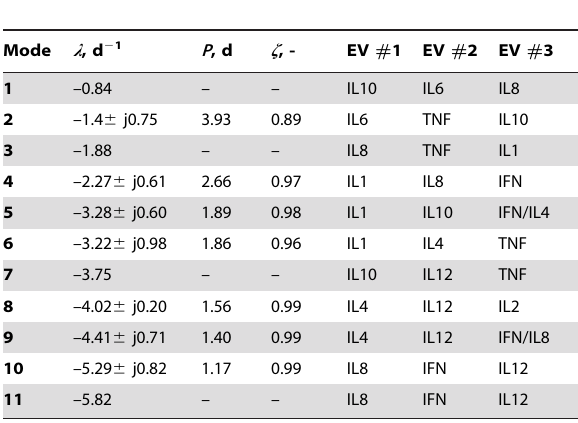
Table 3. Eigenvalues, Periods, Damping Ratios, and Three Highest Eigenvector Magnitudes of A C .